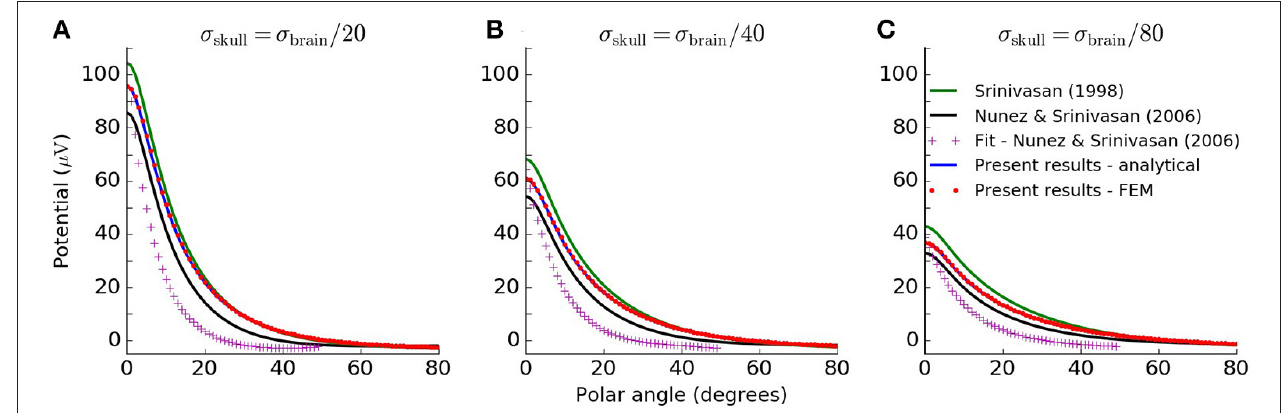
FIGURE 3 | Analytical solution of four-sphere model matches FEM simulation. Scalp potentials from radial current dipole at position r z = 7.8 cm and magnitude 10 − 7 Am to give results in observable range, while still facilitating direct comparison with the original plots in Srinivasan et al. (1998); Nunez and Srinivasan (2006). The resulting scalp potentials are shown for increasing polar angle θ between the current dipole and the measurement position vector. The different lines show calculations with the various formulations of the four-sphere model discussed in this paper, as well as the FEM simulation. The green line shows potentials obtained from Srinivasan et al. (1998), Appendix A, Equations (A1–11). The black line shows results from applying the formulation given in Nunez and Srinivasan (2006), Appendix G, Equations (G.1.9–10) and (G.2.1–10). The approximate solution from Nunez and Srinivasan (2006), Appendix G.4, Equation (G.4.1–3) is given by the pink crosses. The analytical formulation of the four-sphere model presented here is shown in blue, and the FEM simulation is given by the red dots. Panels A–C show results for different values of the skull conductivity, i.e., σ skull = σ brain / 20, σ brain / 40 and σ brain / 80, respectively.